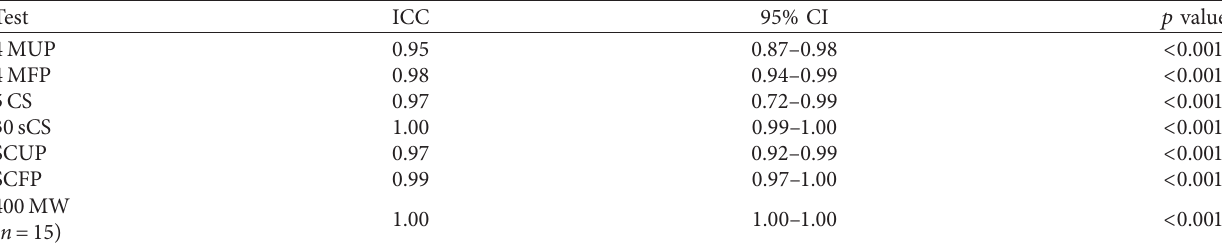
Table 3: Interrater reliability of functional performance testing for three raters for video-recorded scores for time point 1 ( n �